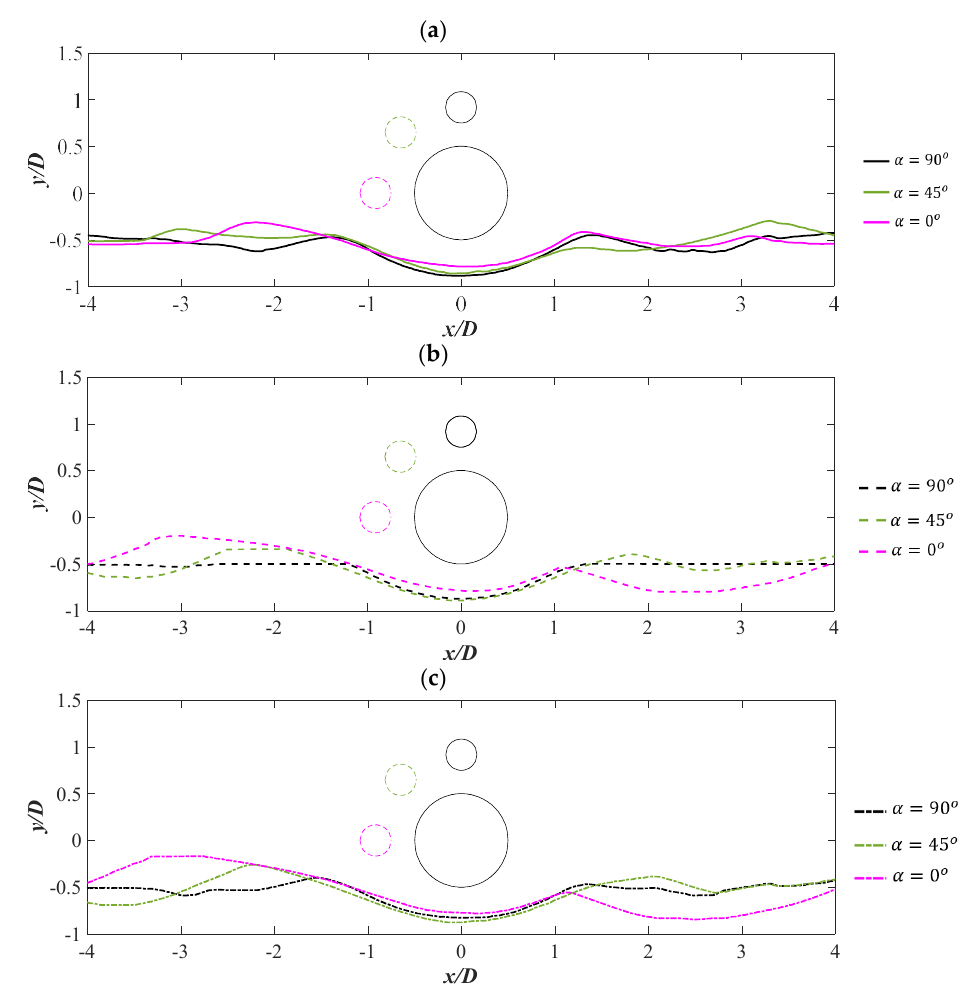
Figure 10. The sediment profiles of the piggyback lines with α = 90 ◦ : black; α = 45 ◦ : green; α = 0 ◦ : magenta at ( a ) t ∗ = 1; ( b ) t ∗ = 1.5 and ( c ) t ∗ = 2 .